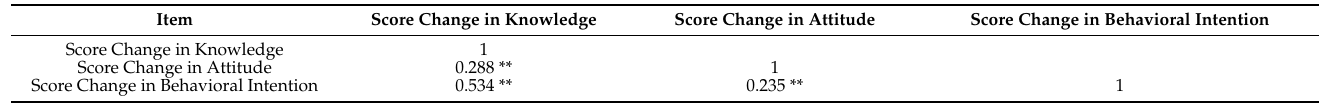
Table 3. Correlation analysis for the score change in knowledge, attitude, and behavioral